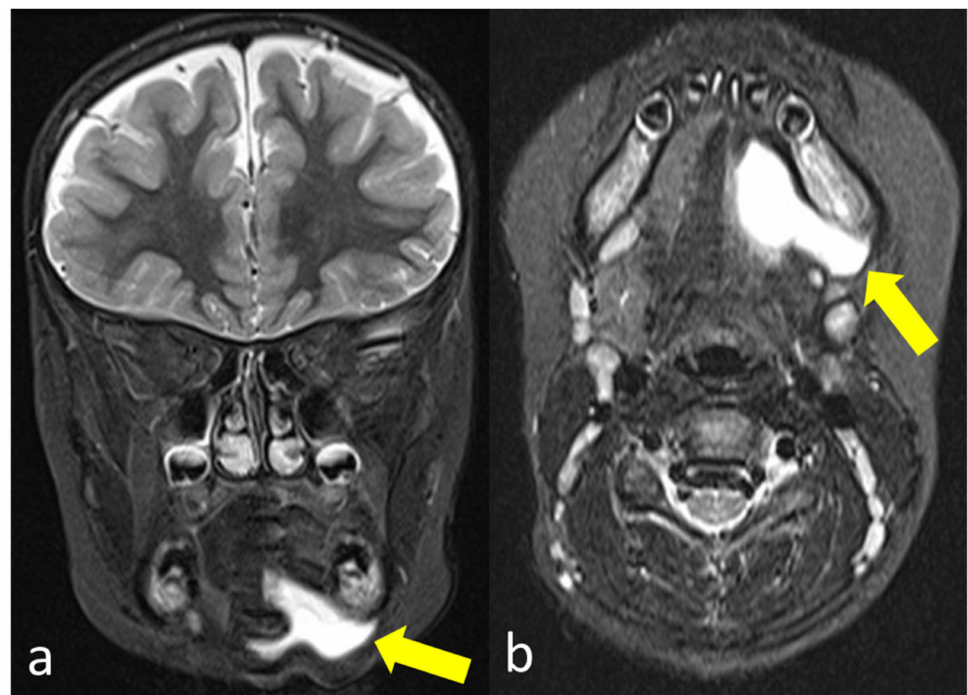
Figure 2. Coronal ( a ) and axial ( b ) MRI with T2-weighted short tau inversion recovery (STIR) sequence showing a hyperintense liquid formation in the left submandibular region (yellow arrows).